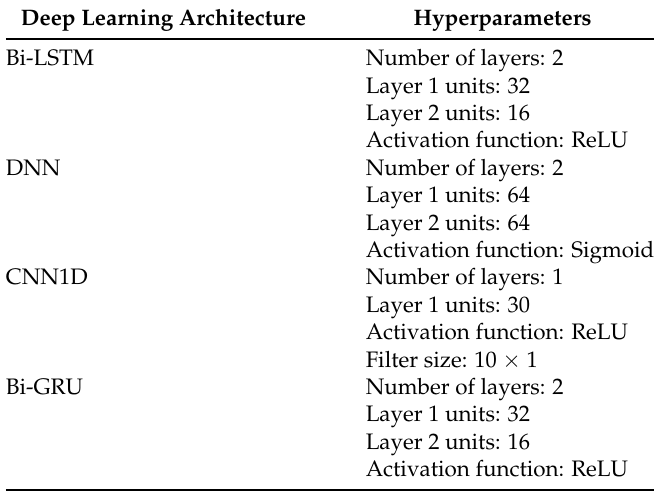
Figure 10. Boxplot of final cost using a combination of gamma value, [1, 2, 3, 4, 5] and alpha value, [0.25, 0.5, 0.75, 1.0]. The x-axis are denoted by the combination of alpha and gamma. For instance, ’g1a100’ represents gamma value of 1 and alpha of 1.0. Table 4. Hyperparameters of all models used to test the focal loss function presented in Section